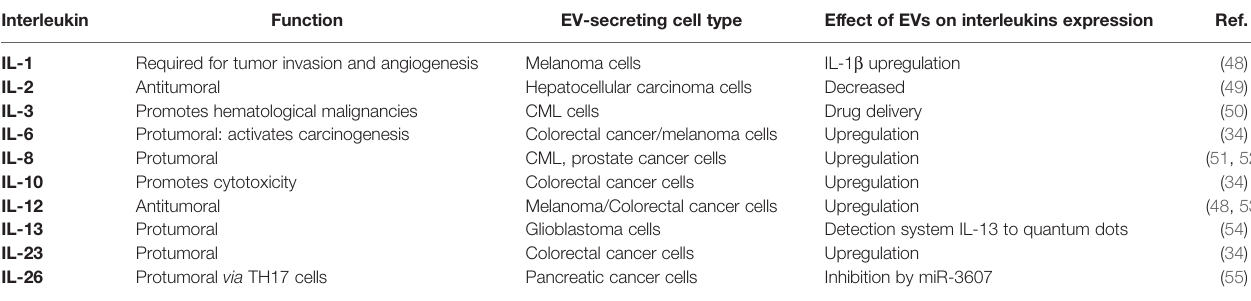
TABLE 1 | Interleukins in cancer and their association with